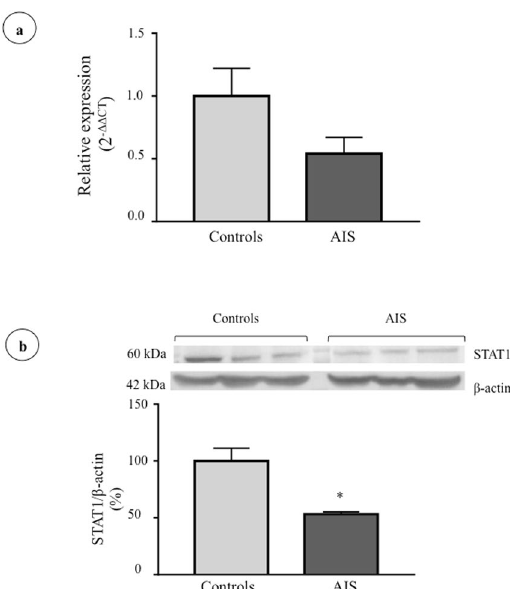
Figure 6. STAT1 gene and protein expression in osteoblasts isolated from control and AIS patients. ( a ) STAT1 gene expression was measured in osteoblasts of controls (n = 7) and AIS patients (n = 13) by RT-qPCR with GAPDH as endogenous control. Relative expression was analyzed with the 2 −ΔΔ CT method. ( b ) STAT-1 protein expression was evaluated by Western blot (n = 3/group) and β -actin was used as endogenous control. * P < 0.05 using two-tailed Student’s t-test. Data are presented as mean ± standard